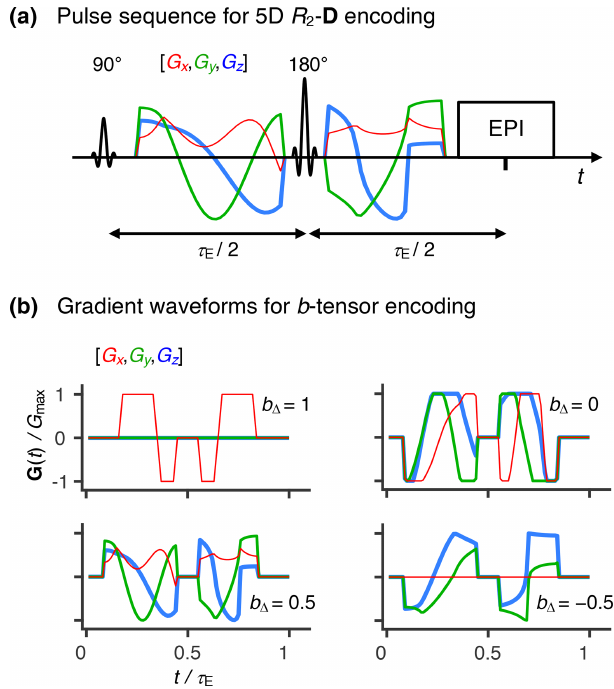
Figure 1. Acquisition protocol for 5D relaxation–diffusion MRI. (a) Pulse sequence for acquiring images encoded for relaxation and diffusion in a 5D space defined by the echo time τ E , and b - tensor trace b , normalized anisotropy b (cid:49) , and orientation ( (cid:50) , (cid:56) ). An EPI image readout block acquires the spin echo produced by slice-selective 90 and 180 ◦ radio-frequency pulses. The 180 ◦ pulse is encased by a pair of gradient waveforms allowing for diffusion encoding according to principles from multidimensional solid-state NMR (Topgaard, 2017) (red, green, and blue lines). The signal is encoded for the transverse relaxation rate R 2 by varying the value of τ E . (b) Numerically optimized gradient waveforms (Sjölund et al., 2015) yielding four distinct b -tensor shapes ( b (cid:49) = − 0 . 5, 0.0, 0.5, and 1) (Eriksson et al.,